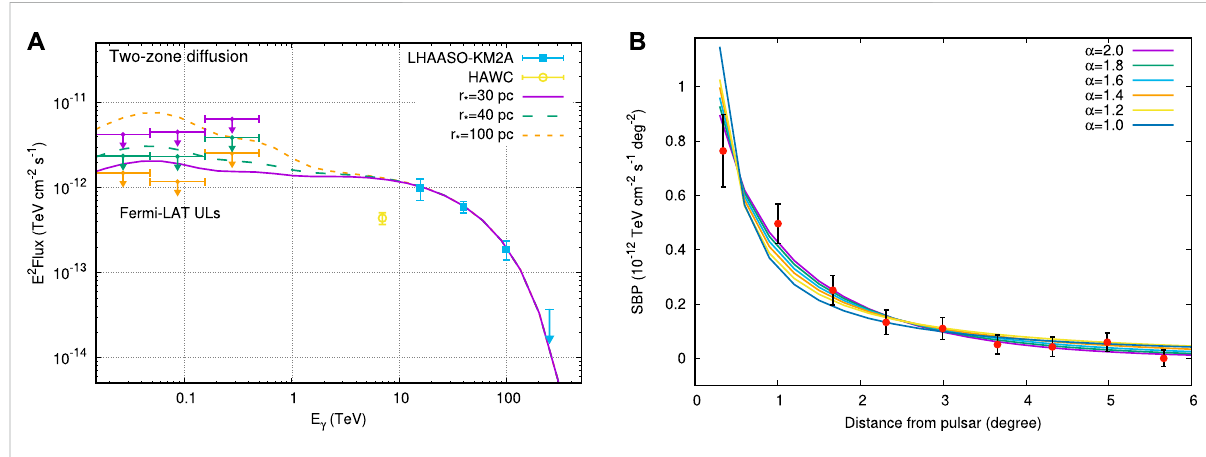
FIGURE 4 (A) : Interpretation of the wide-band gamma-ray spectrum of LHAASO J0621 + 3755 with two-zone diffusion models (Fang et al., 2021). Different sizes oftheslow-diffusion zoneare adopted. The Fermi-LAT ULsvarywith themodels. (B) Fitting results oftheGeminga halo ’ sgamma-ray pro fi le measured by HAWC with superdiffusion models (Wang et al., 2021), where α is the superdiffusion index. Superdiffusion degenerates to the normal diffusion when α =